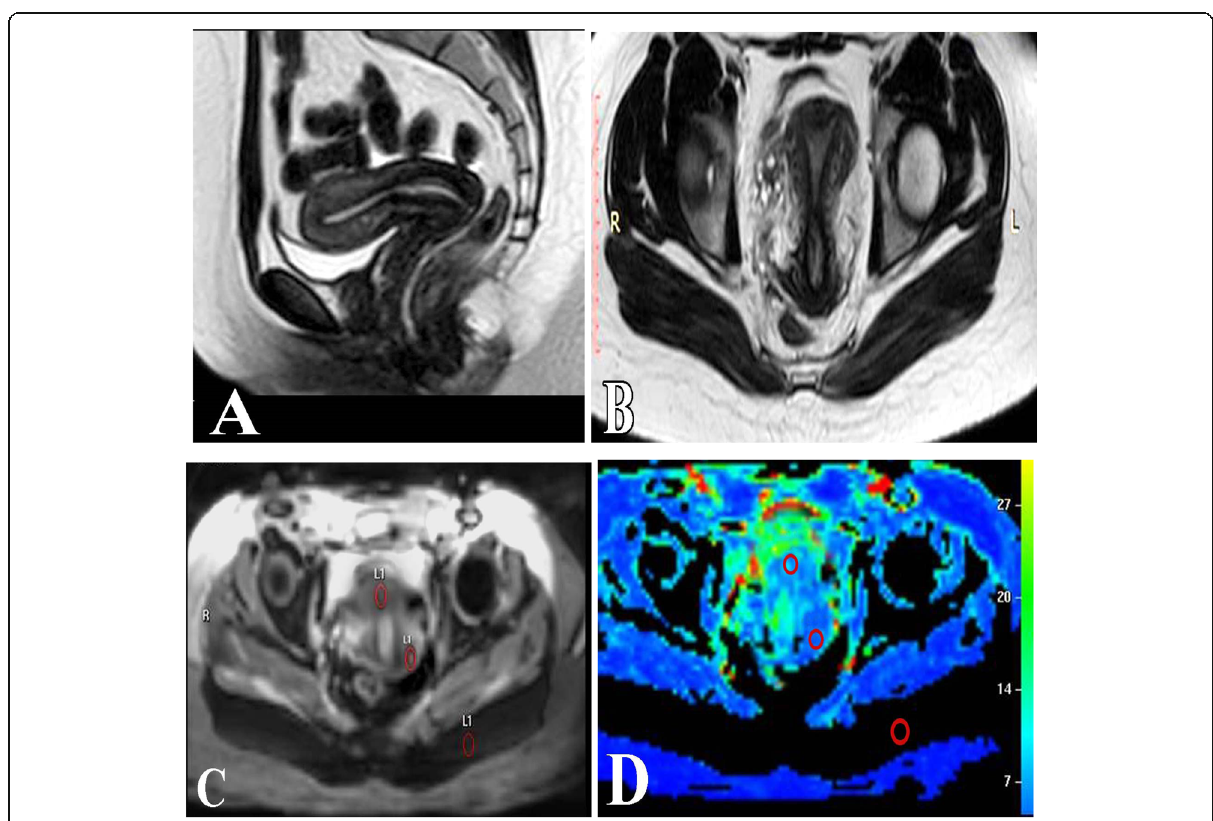
Fig. 2 Normal control female case aged 30 years old. a , b Sagittal and axial T2WI of the uterus. c ASL gray scale map with the ROIs put at the anterior wall, posterior wall of the uterus, and in the gluteus muscle. d ASL color map with the ROIs put at the anterior wall, posterior wall of the uterus, and in the gluteus muscle. In this case, the ASL perfusion in the anterior wall was 243 and in the posterior wall was